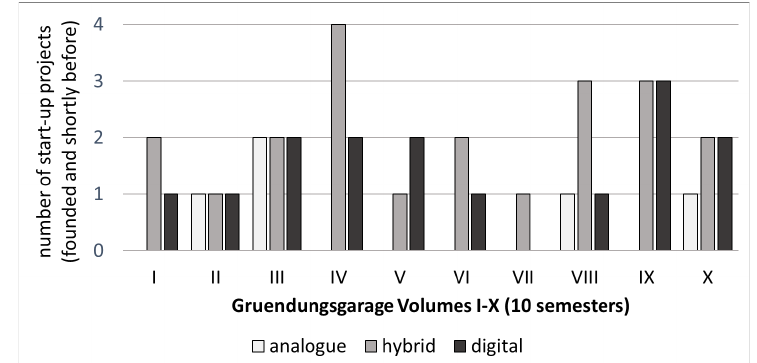
Fig. 3. Digitalization of the start-up projects business models over